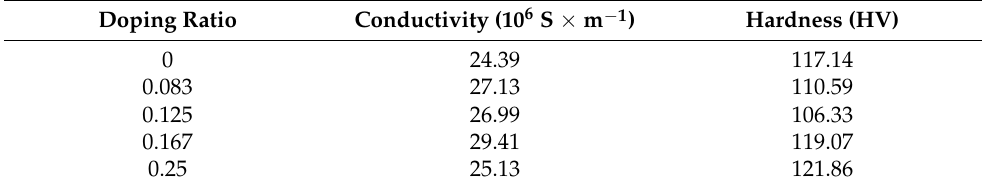
Table 6. Physical property of contact